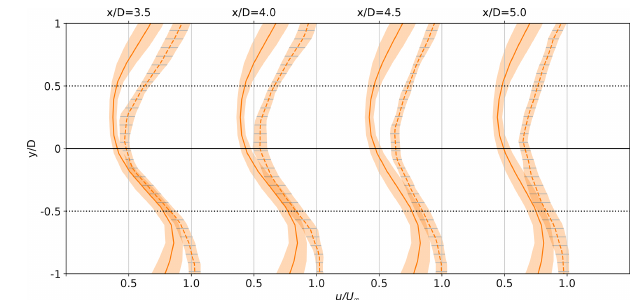
Figure 20. Comparison of far-wake velocity wake deficit at down- stream locations from turbine C06 for the case CNk4 1 . Line at y/D = 0 is perpendicular to the turbine orientation from SCADA data. Shaded area represents 95% confidence interval on the mean.